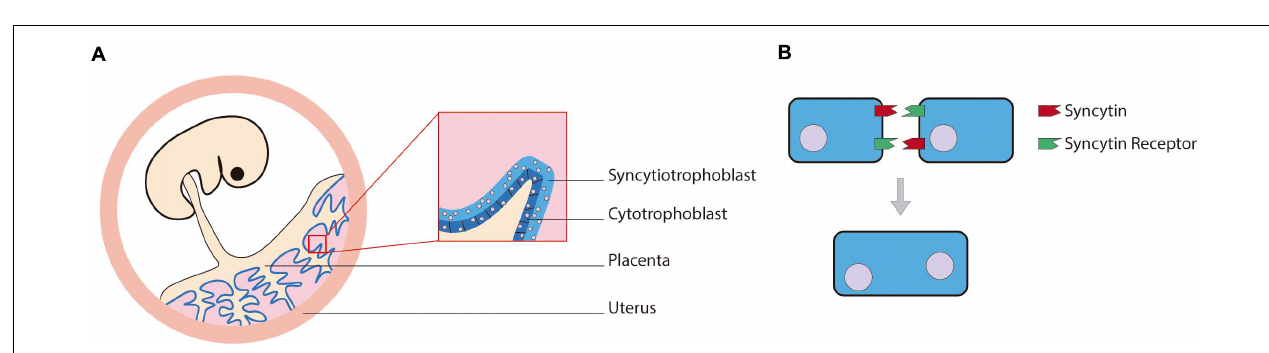
FIGURE 3 | (A) Human example of the syncytiotrophoblast location in the placenta alongside (B) a diagram of the syncytium formation mediated by syncytins.